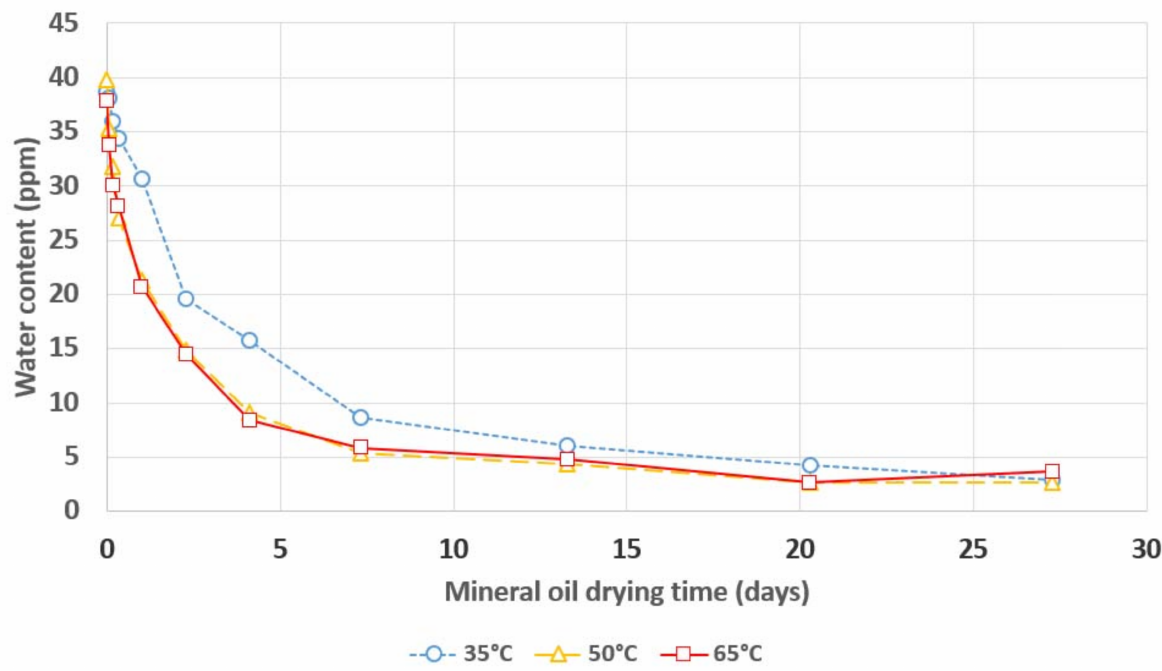
Figure 2. Water content in mineral oil during its drying with a 3A molecular